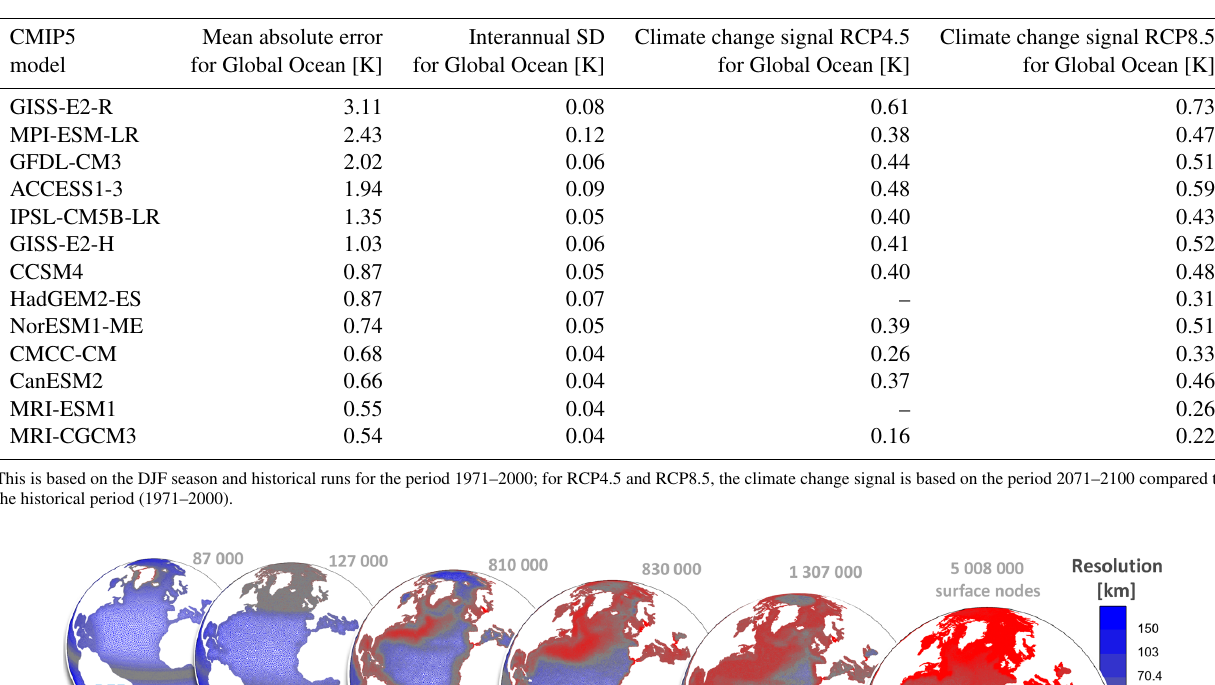
Table 1. CMIP5 models considered in the illustration of the deep ocean bias in Fig. 1, in decreasing order according to their mean absolute potential temperature error at 1000m depth. The absolute error is computed at every grid point as the absolute difference | T m − T o | , where T o is the observed and T m is the modeled potential temperature.